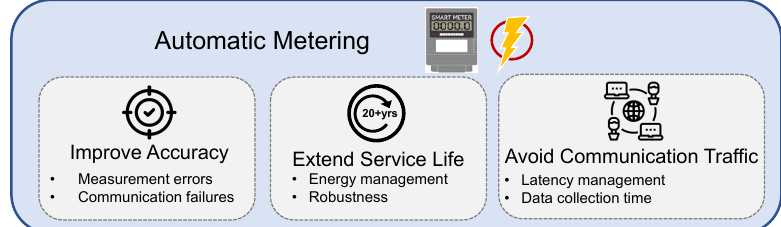
Figure 9. Essential factors for automatic